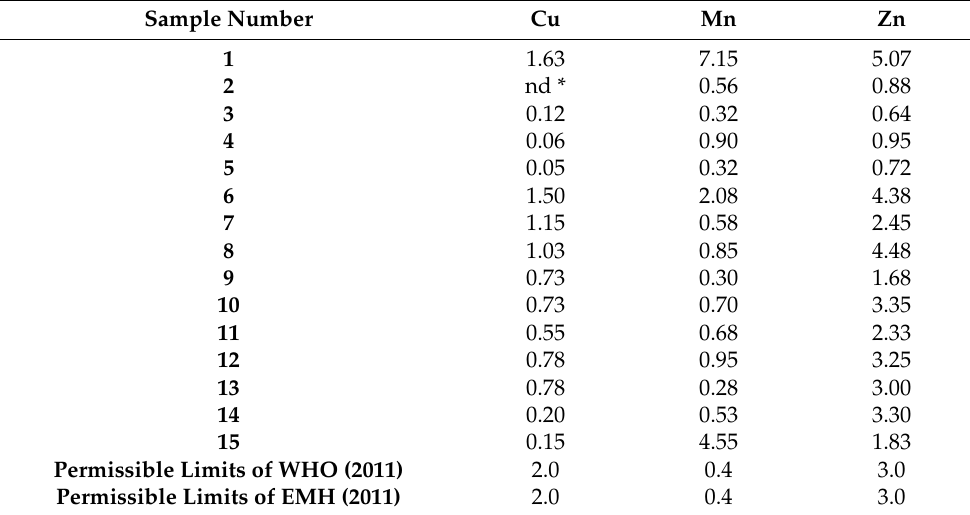
Table 1. The concentrations of Cu, Mn, and Zn (mg L − 1 ) in the drinking water samples from the study